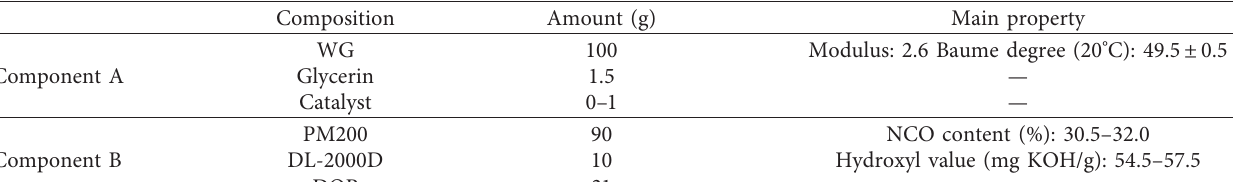
Table 1: Compositions of the PU/WG grouting materials.